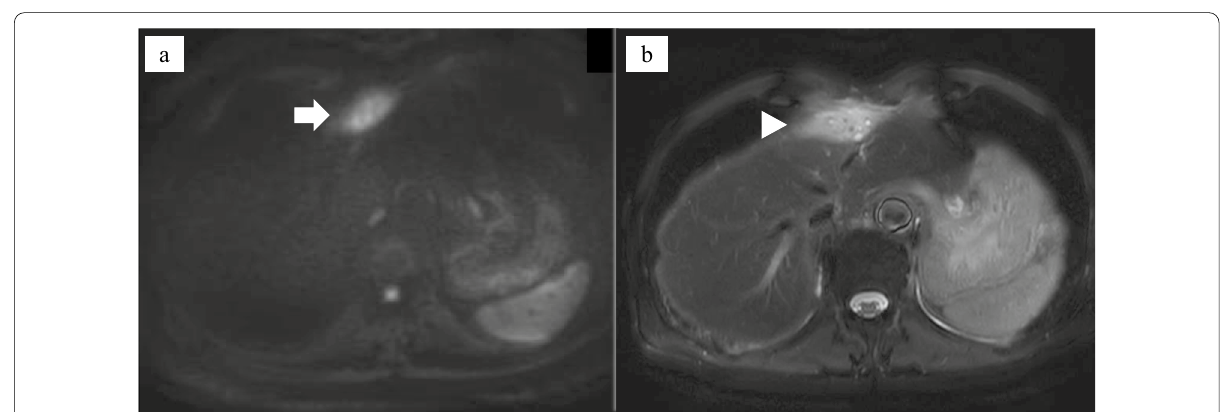
Fig. 2 Magnetic resonance imaging (MRI) of the falciform ligament abscess at the time of the first admission. a The falciform ligament mass showed high signal intensity on diffusion-weighted images (white arrow). b Small high-intensity areas within the mass were visible on T2-weighted images (white